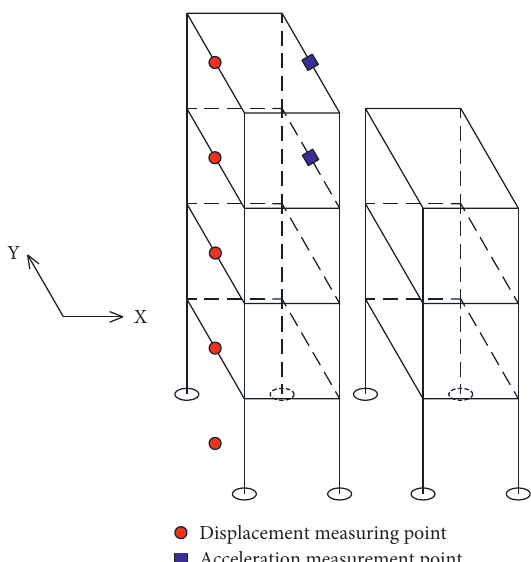
Figure 10: Layout of the measuring